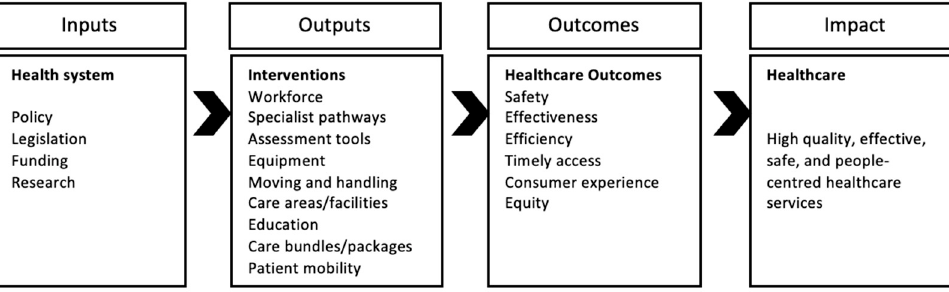
Figure 1. Conceptual framework of interventions and outcomes for quality healthcare.